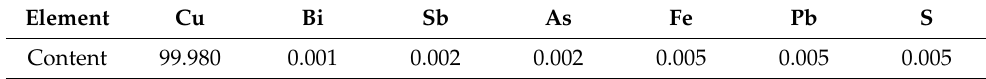
Table 1. Copper Material chemical composition